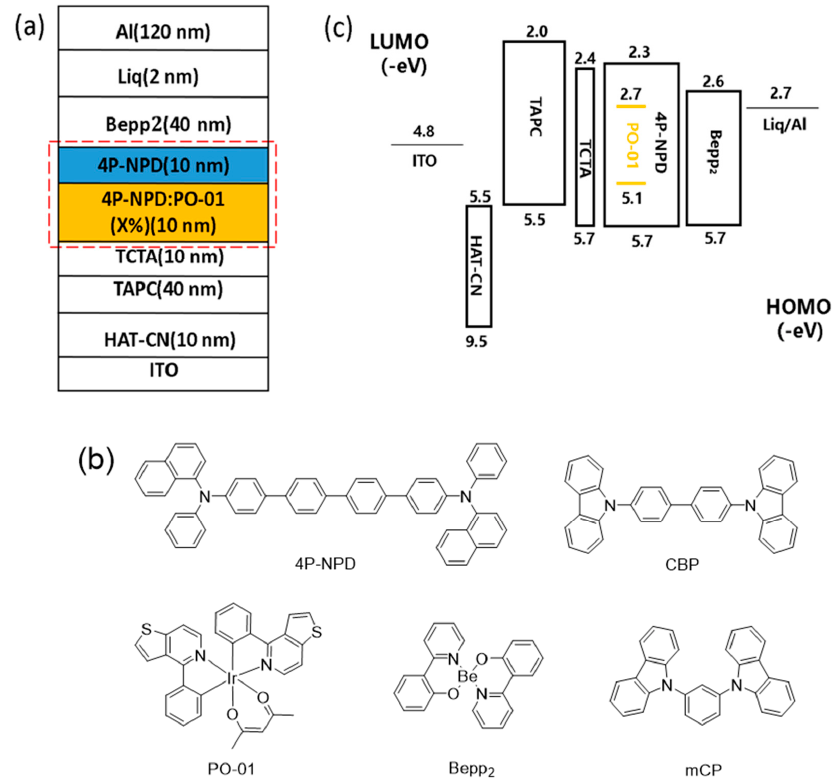
Figure 1. ( a ) Schematic structure of the white organic light-emitting diode (WOLED). ( b ) Chemical structure of organic materials used in the WOLED. ( c ) Energy level diagram of the WOLED. ITO: indium tin oxide; HAT-CN: dipyrazino [2–f:2 (cid:48) ,3 (cid:48) -h] quinoxaline-2,3,6,7,10,11-hexacarbonitrile; Liq: